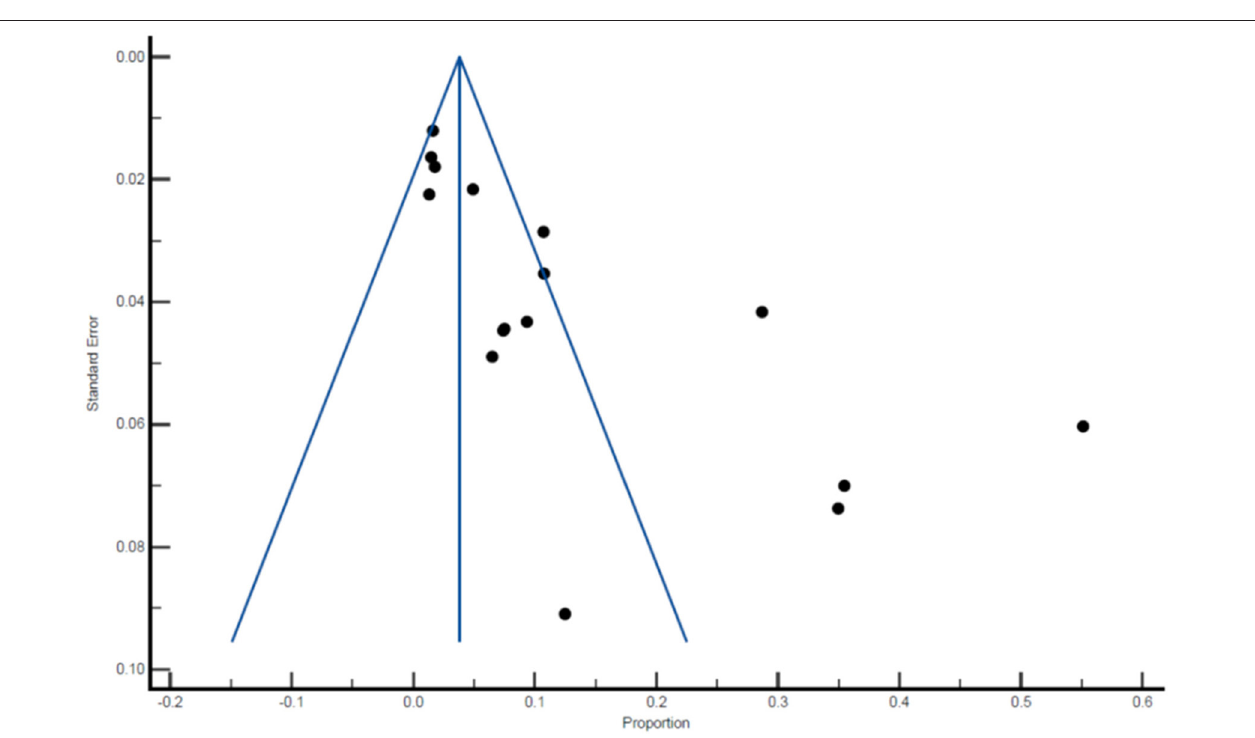
Frontiers in Global Women’s Health |